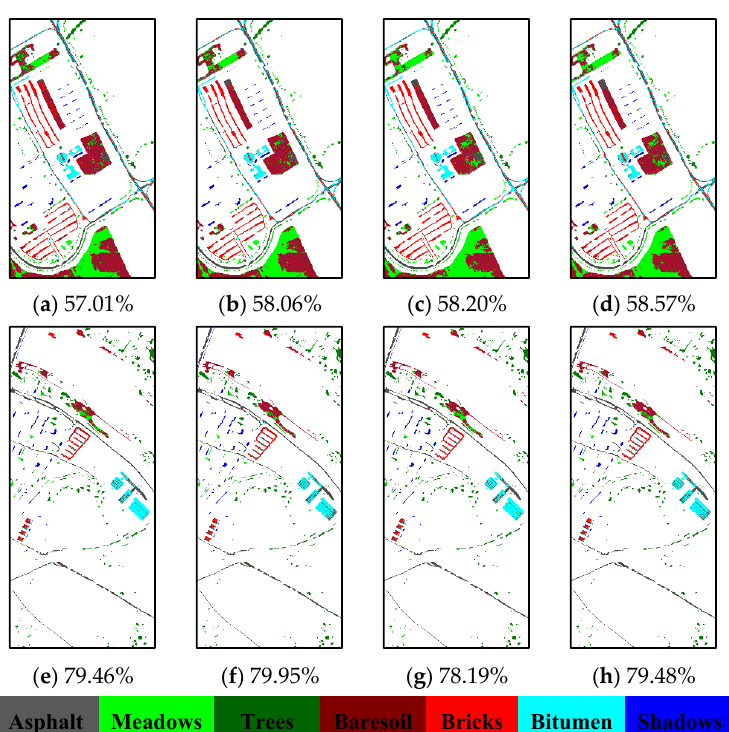
Figure 15. Classification maps (limited to validation/training sample locations) for GFKSVM on ROSIS data: Center → University: ( a ) PCA-PCA; ( b ) rPCA-rPCA; ( c )-FA-FA; ( d ) NNMF-NNMF; University → Center: ( e ) PCA-PCA; ( f ) rPCA-rPCA; ( g )-FA-FA; ( h ) NNMF-NNMF.